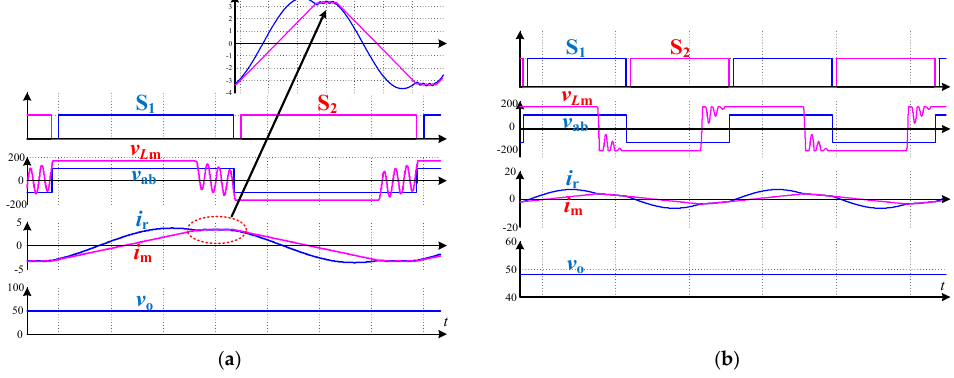
Figure 12. Simulation waveforms under different loads ( f = 0.8 f r ): ( a ) full load ( P = 150 W); ( b ) heavy load ( R = 6, P = 384 W).